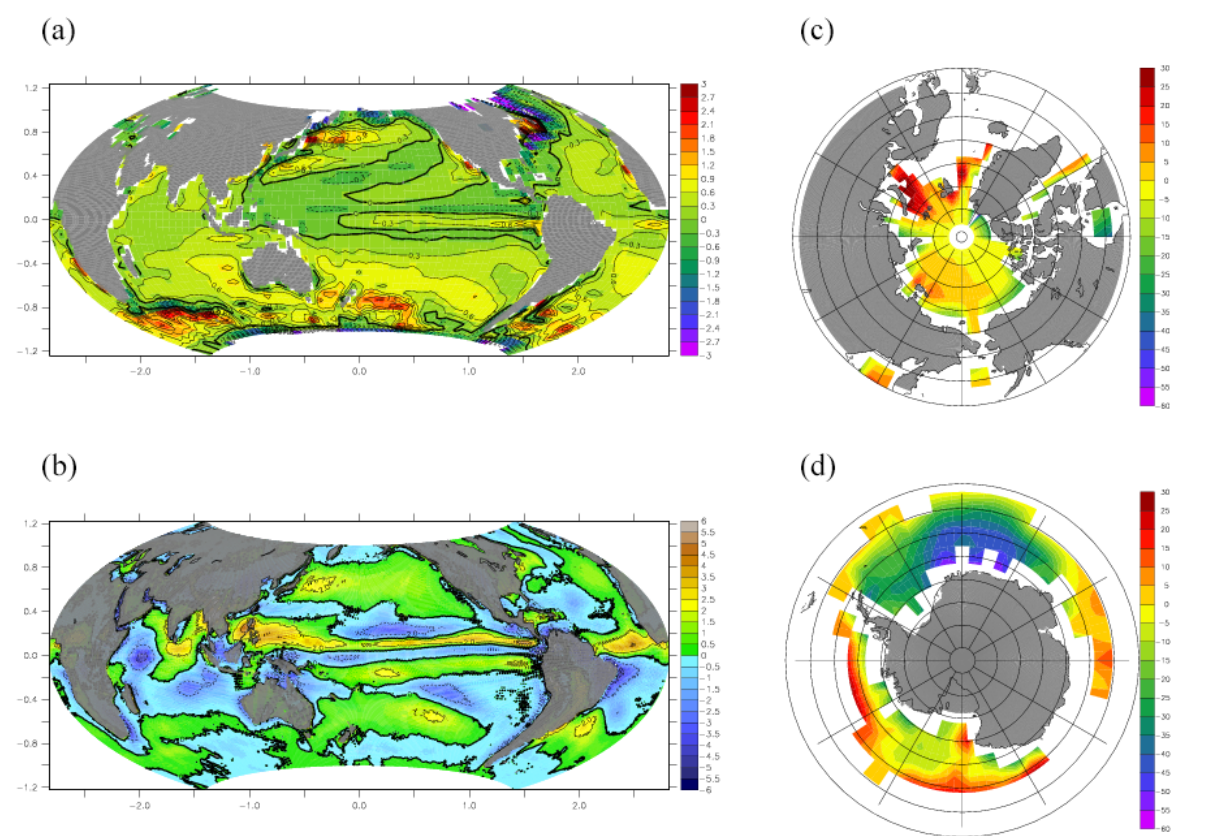
Figure 1. (a) Sea surface temperature differences ( ◦ C) between the CTR and the NOAA OI Sea Surface Temperature V2. (b) E − P flux differences (mmday − 1 ) between the control simulation and the ERAI. Sea ice area differences (%) between the CTR and the HadISST estimates for the (c) Northern Hemisphere and (d) Southern